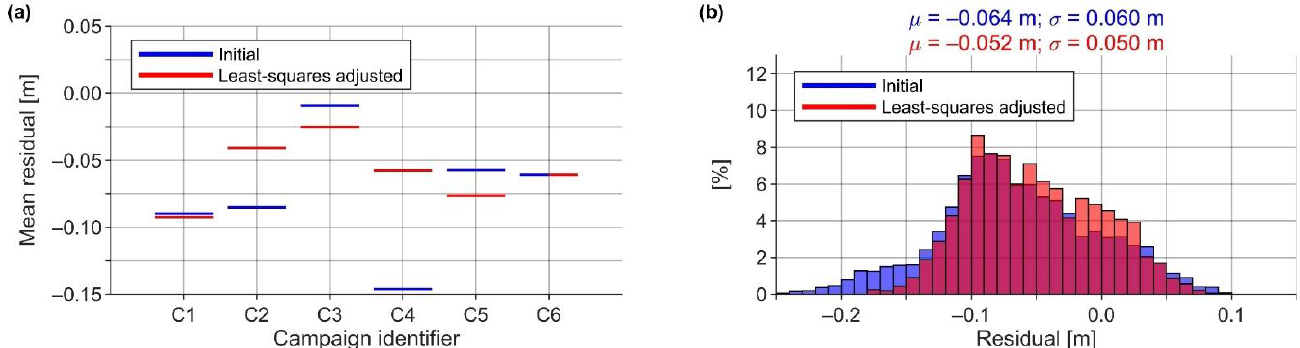
Figure 16. The ( a ) mean values of residuals (the initial ones coincide with those in Figure 14a) and ( b ) histograms of residuals (all campaigns combined).